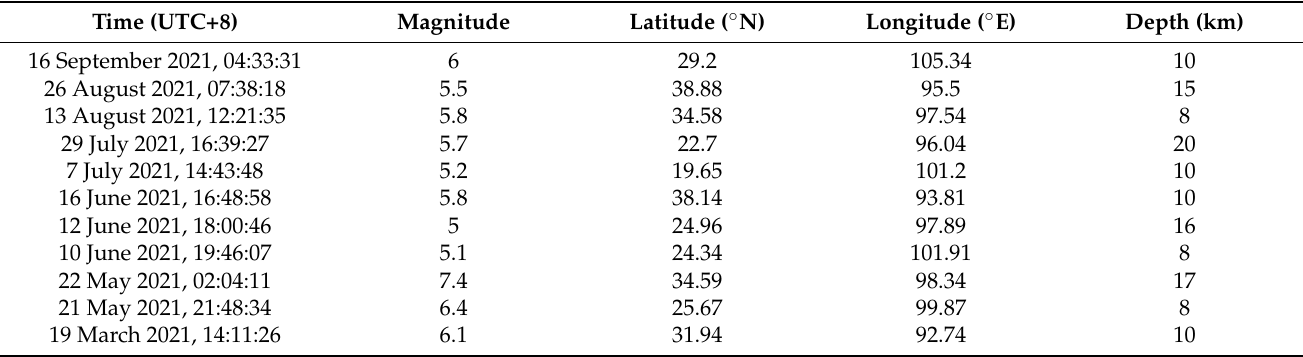
Table 7. The considered earthquakes with a pre-seismic